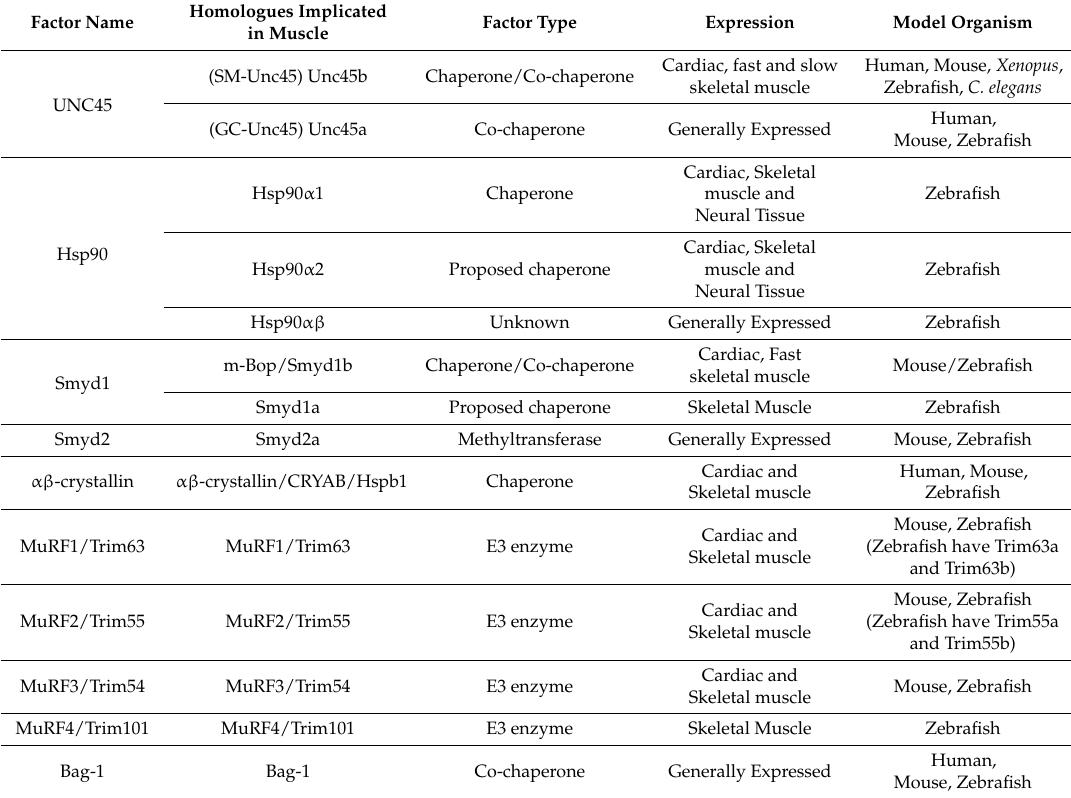
Table 2. Factors implicated in sarcomere assembly and